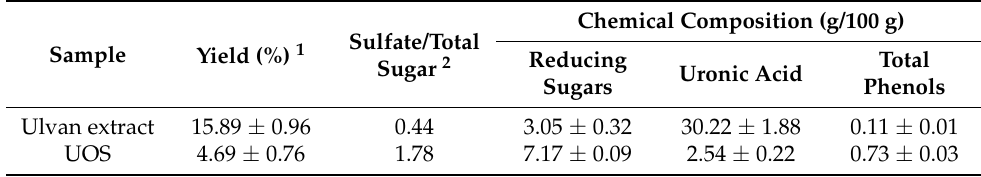
Chemical Composition (g/100 g) Sulfate/Total Total Reducing Sugar 2 Uronic Acid Phenols Sugars